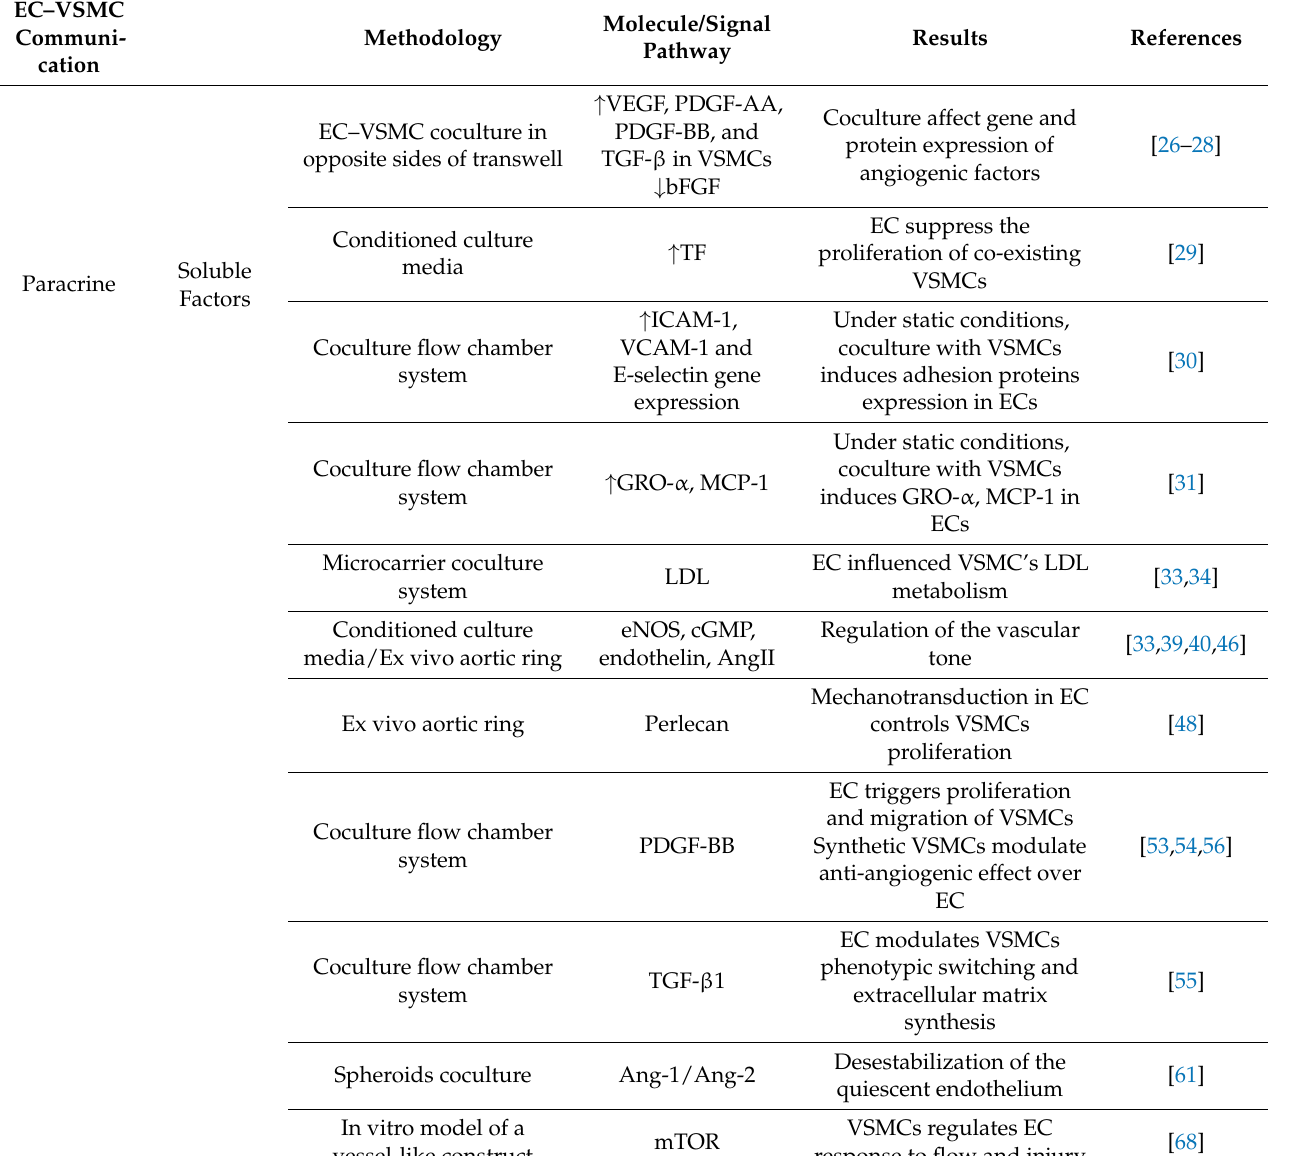
Table 1. Summary of the EC–VSMC crosstalk, define by different in vitro